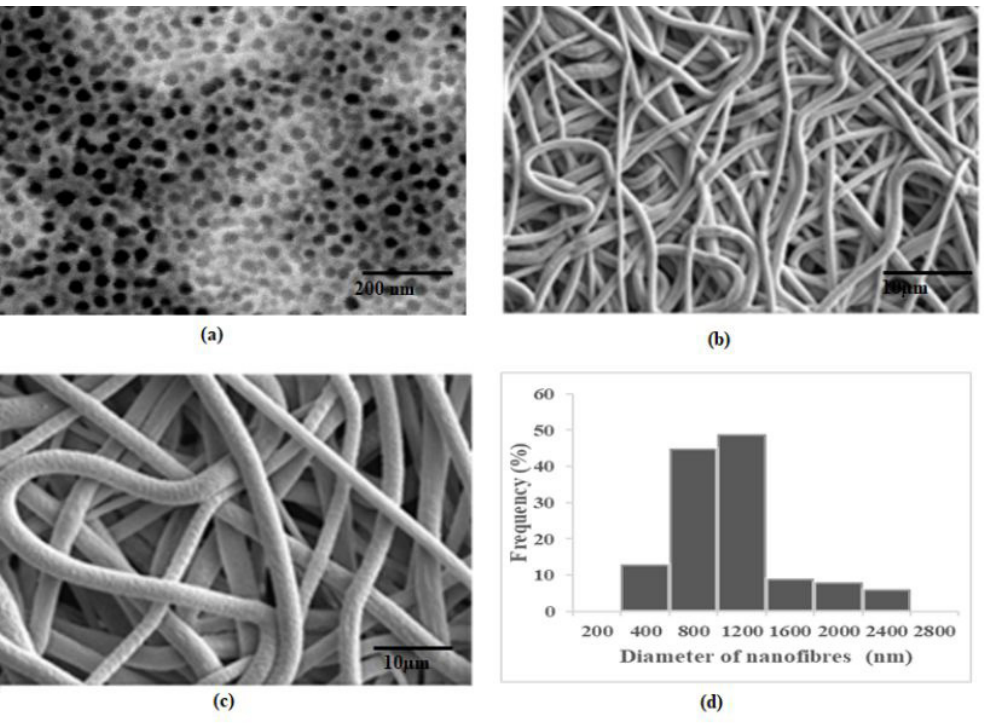
, (b) and (c) Group 2 – Nanotubes of TiO 2